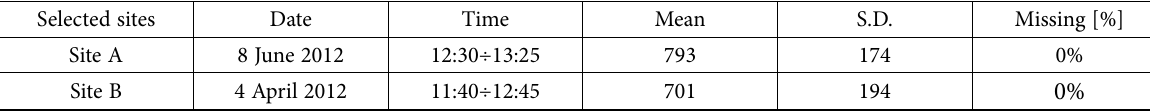
Table 2. Descriptive statistics of traffic data used in Scenario